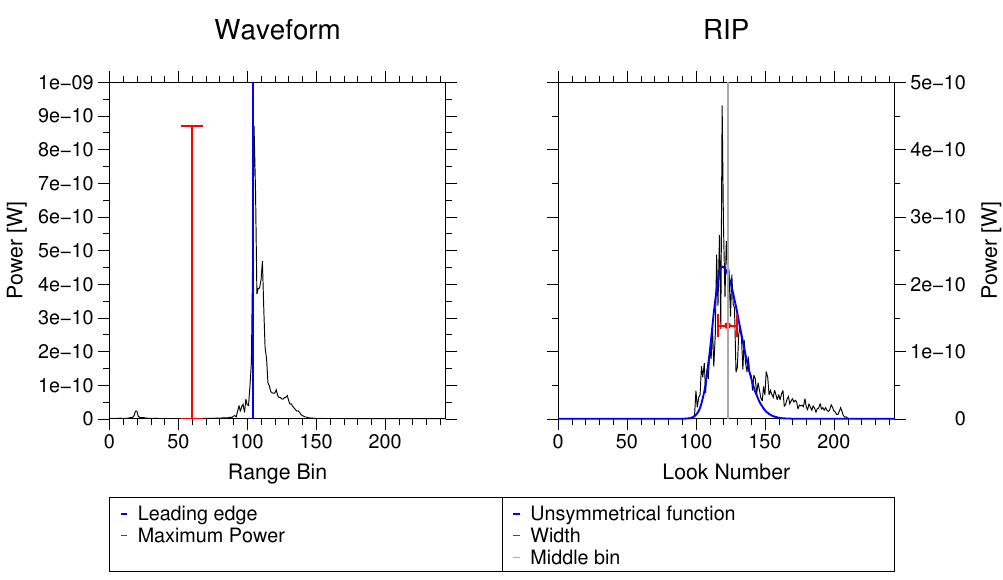
Figure 4. One example of a waveform and the corresponding RIP with some of their derived